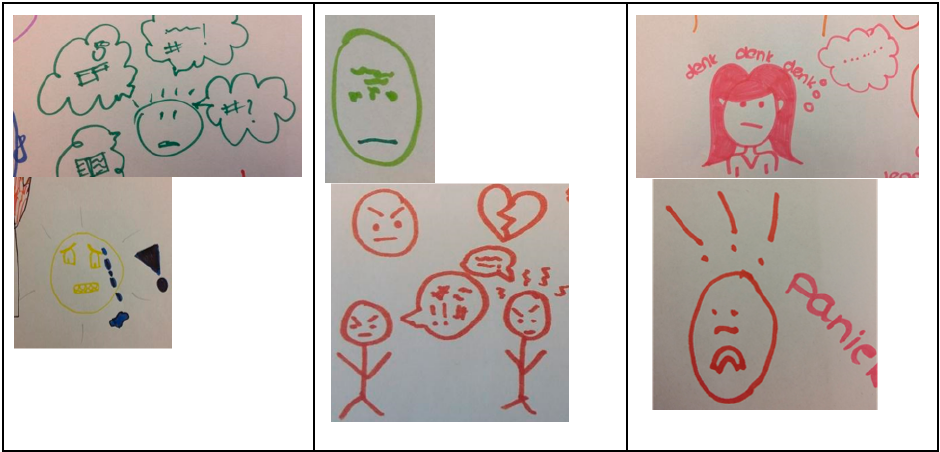
Figure 9. Visualisation questionnaires.